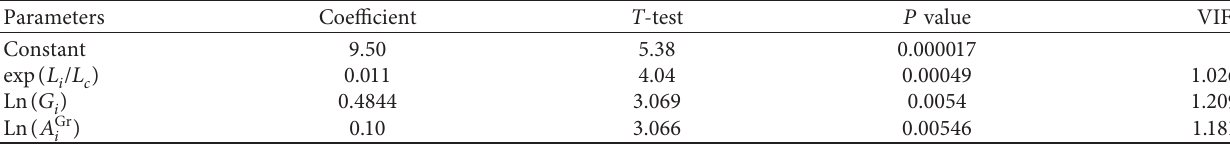
Table 5: Empirical GDP model (adjusted R 2 � 0 . 6574).